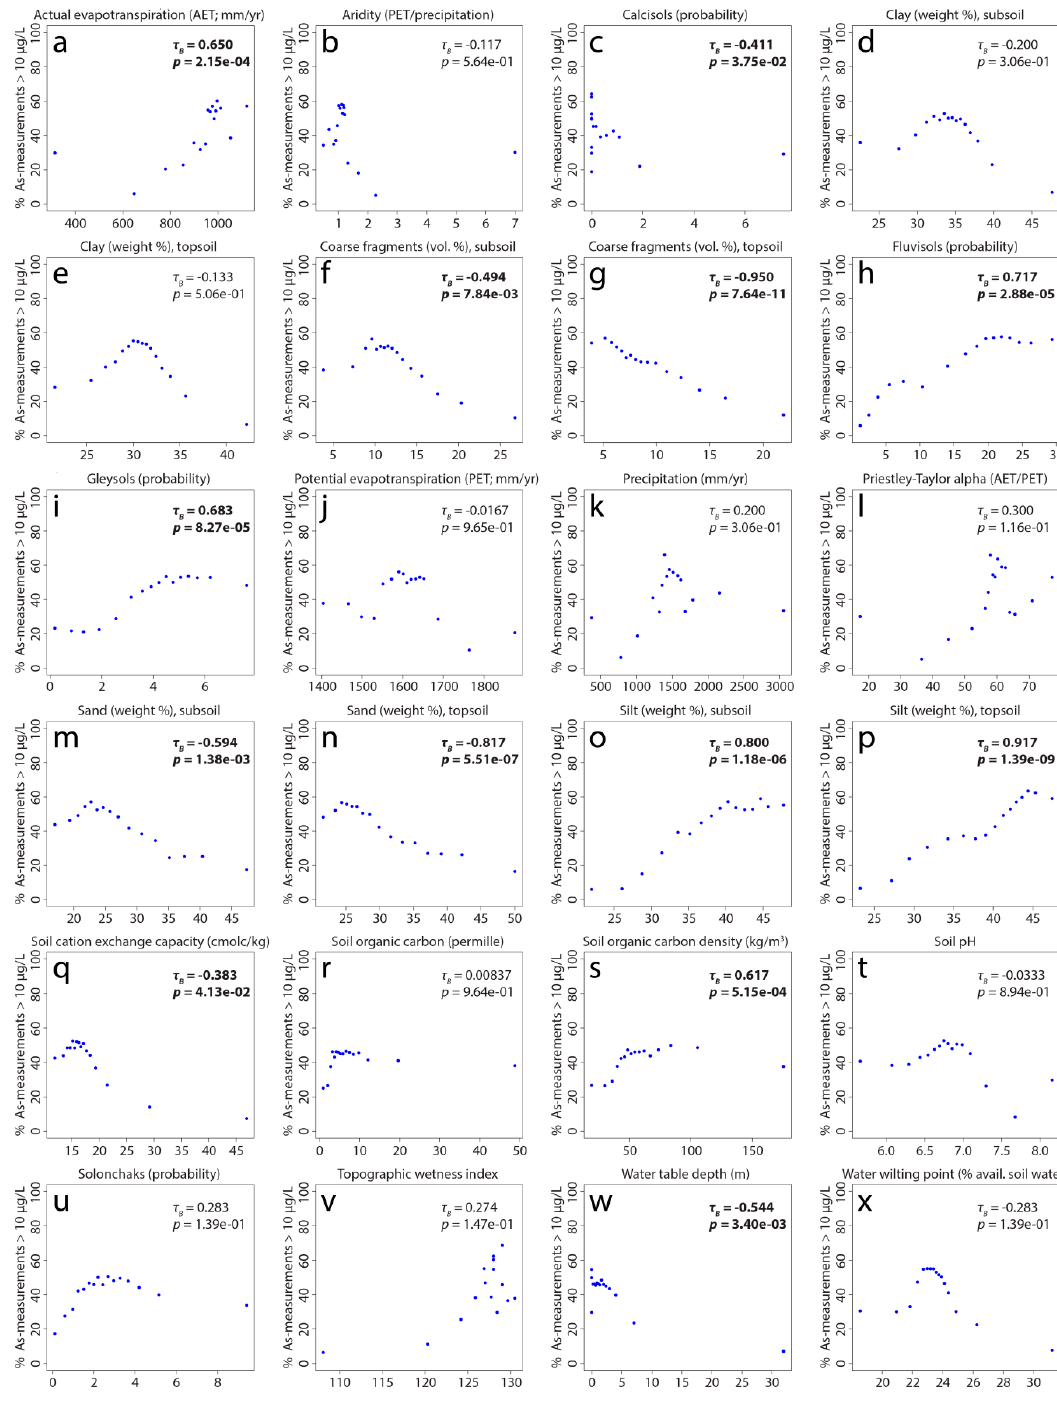
Figure 4. Correlations of predictor variables ( a )–( x ) with percentages of arsenic data points exceeding 10 µg/L in 16 equally sized bins. Kendall correlations ( τ B ) with a statistically significant p value (95% confidence level) are shown in bold.